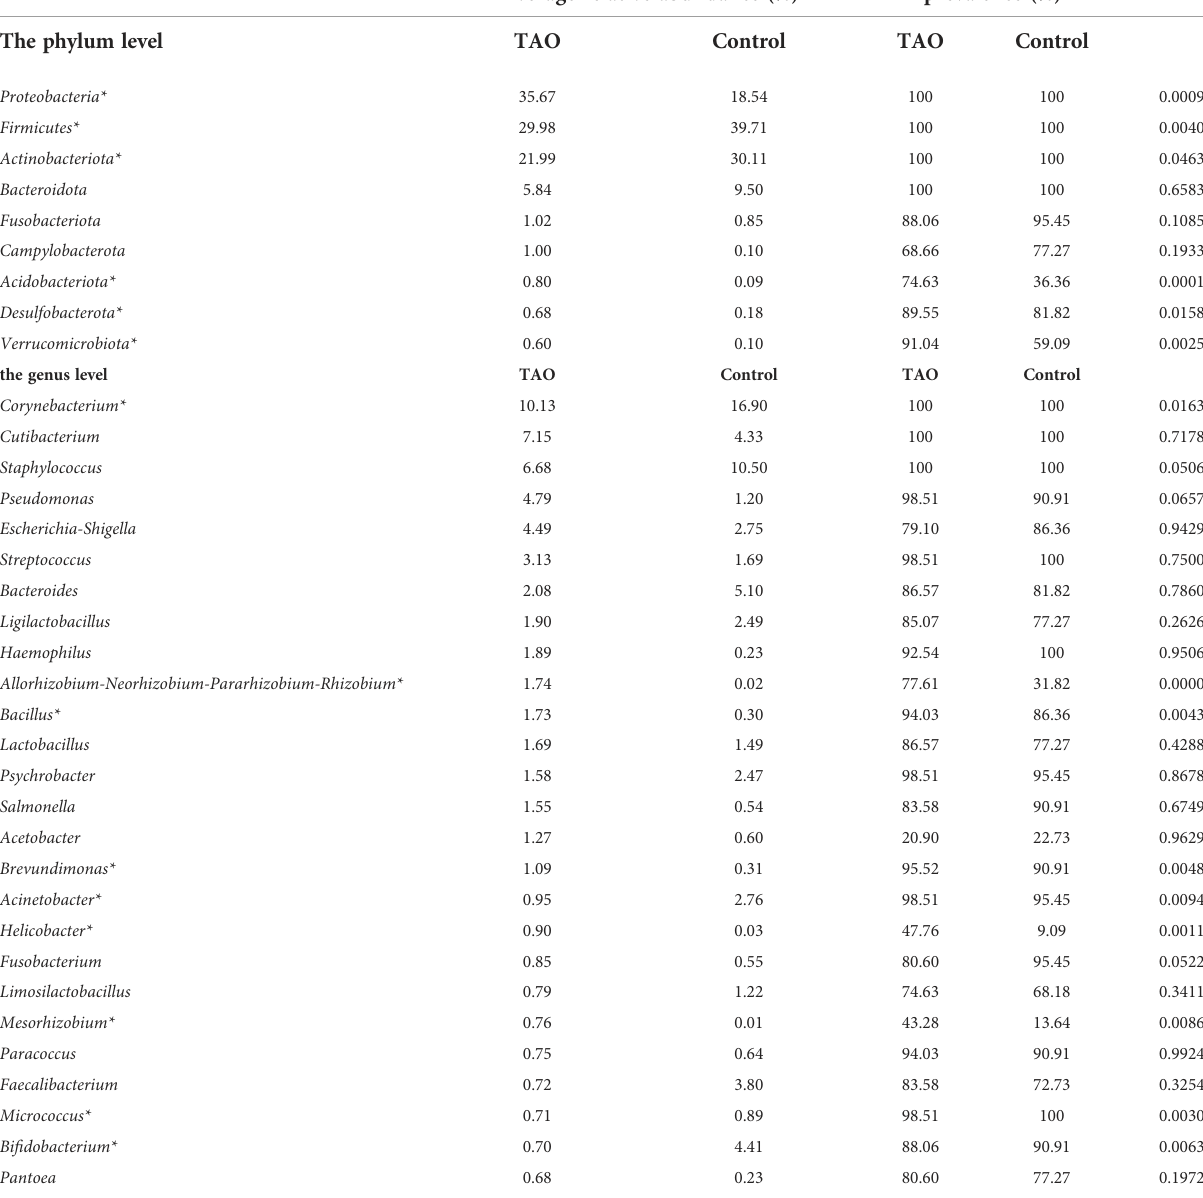
TABLE 2 Features of dominant